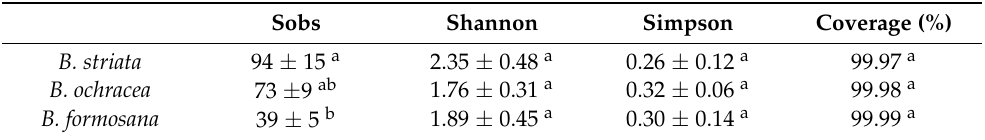
Table 1. Alpha diversity estimates of root endophytic fungi associated with Bletilla . Data were analyzed by one-way ANOVAs with Tukey HSD post hoc comparisons. Significant differences ( p < 0.05) among different species for each index are indicated by differences in lowercase letters. Sobs